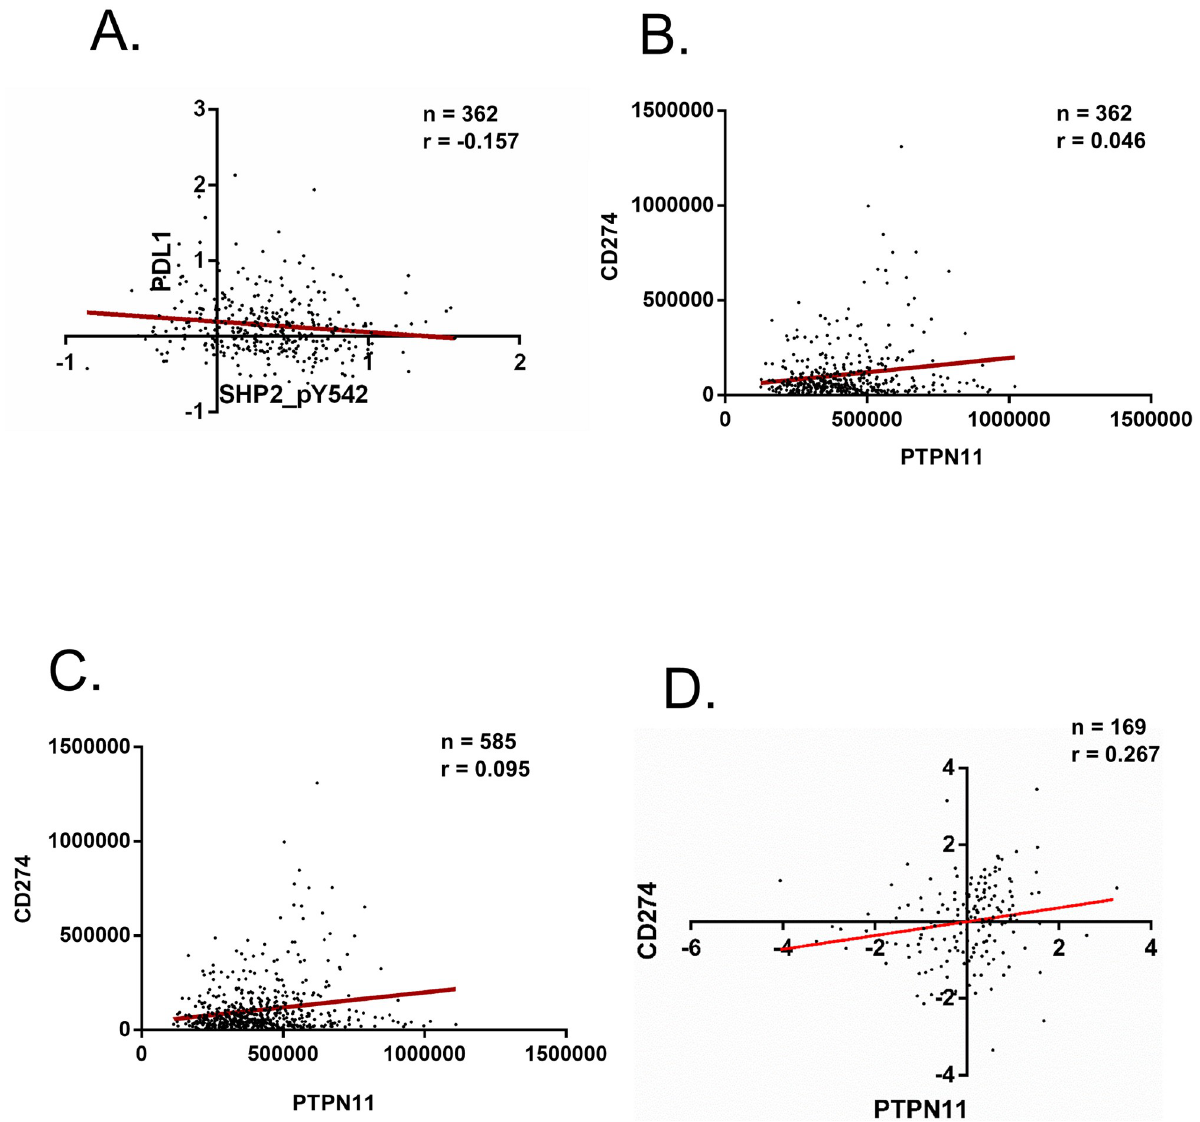
Fig 1. SHP-2 activity and expression correlates with expression of PD-L1 in NSCLC adenocarcinomas. A . Two-tailed non-parametric Spearman correlation analysis of RPPA protein expression data for Y542 phosphorylated SHP-2 and PD-L1 from 362 adenocarcinomas taken from The Cancer Proteome Atlas (TCPA: https://gdc.cancer.gov/about-data/publications/pancanatlas) LUAD-L4 dataset. B . Two-tailed non-parametric Spearman correlation analysis of bulk RNA-seq FPKM-UQ values taken from TCGA (GDC) for the 362 patients that had corresponding RPPA protein expression data from TCPA. C . Two-tailed non-parametric Spearman correlation analysis of bulk RNA-seq FPKM-UQ values taken from TCGA (GDC) for all 585 patients in the TCGA-LUAD dataset. D . Two-tailed non-parametric Spearman correlation analysis of mRNA z-scores taken from cBioPortal (PMID:32015526) for 169 lung adenocarcinoma tumors. The red line in each panel represents a linear regression line of best fit.